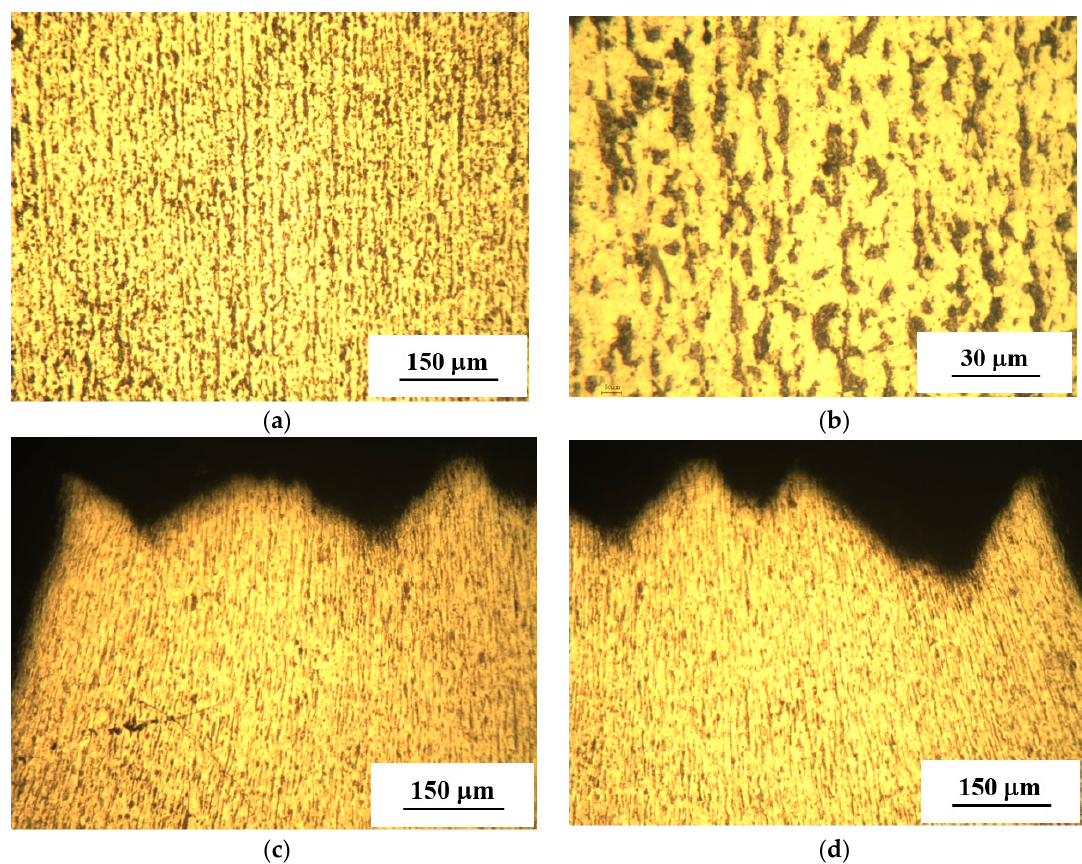
Figure 3. Microstructure of the fragment under investigation taken from the “Gorky ‐ Center” gas pipeline steel (Gavrilovskaya CS): ferrite ‐ perlite structure with striped morphology ( a , b ); microstructure of the tensile failed specimen in the neck region ( c , d ).